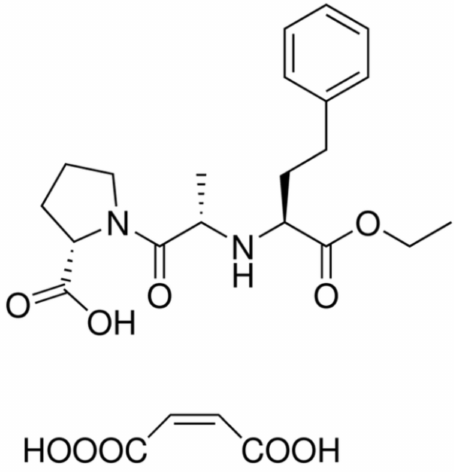
Figure 1. Structural formula of enalapril